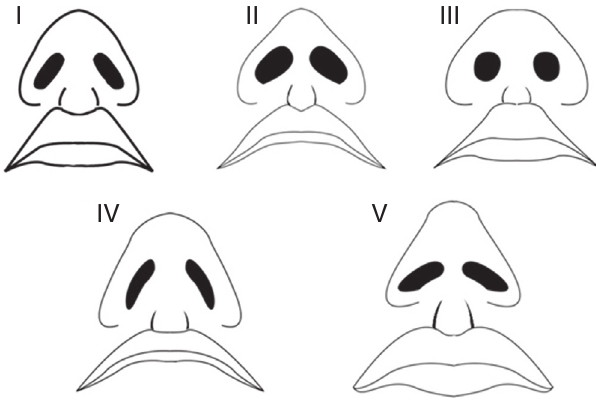
Figure 2 Nostril models in young Turkish females. Figure 3 Nostril models in young Turkish females.